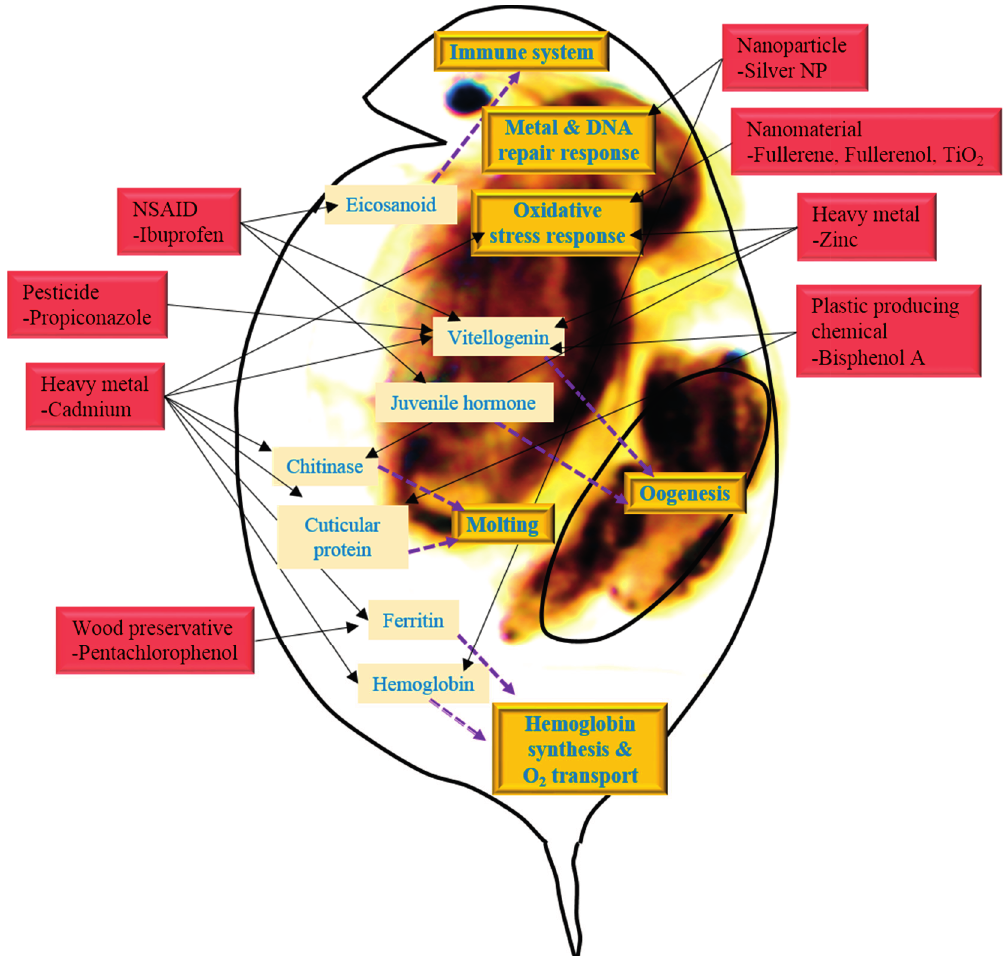
Figure 4. A scheme showing overview of biomarkers and biological interactions in Daphnia in response to stressors (as indicated 3-D red square). These candidate genes might be considered as potential biomarkers (as indicated in pink square), and their products are involved in important biological processes (as indicated in 3-D orange square) via interference with certain biomolecules (as indicated in 2-D pink